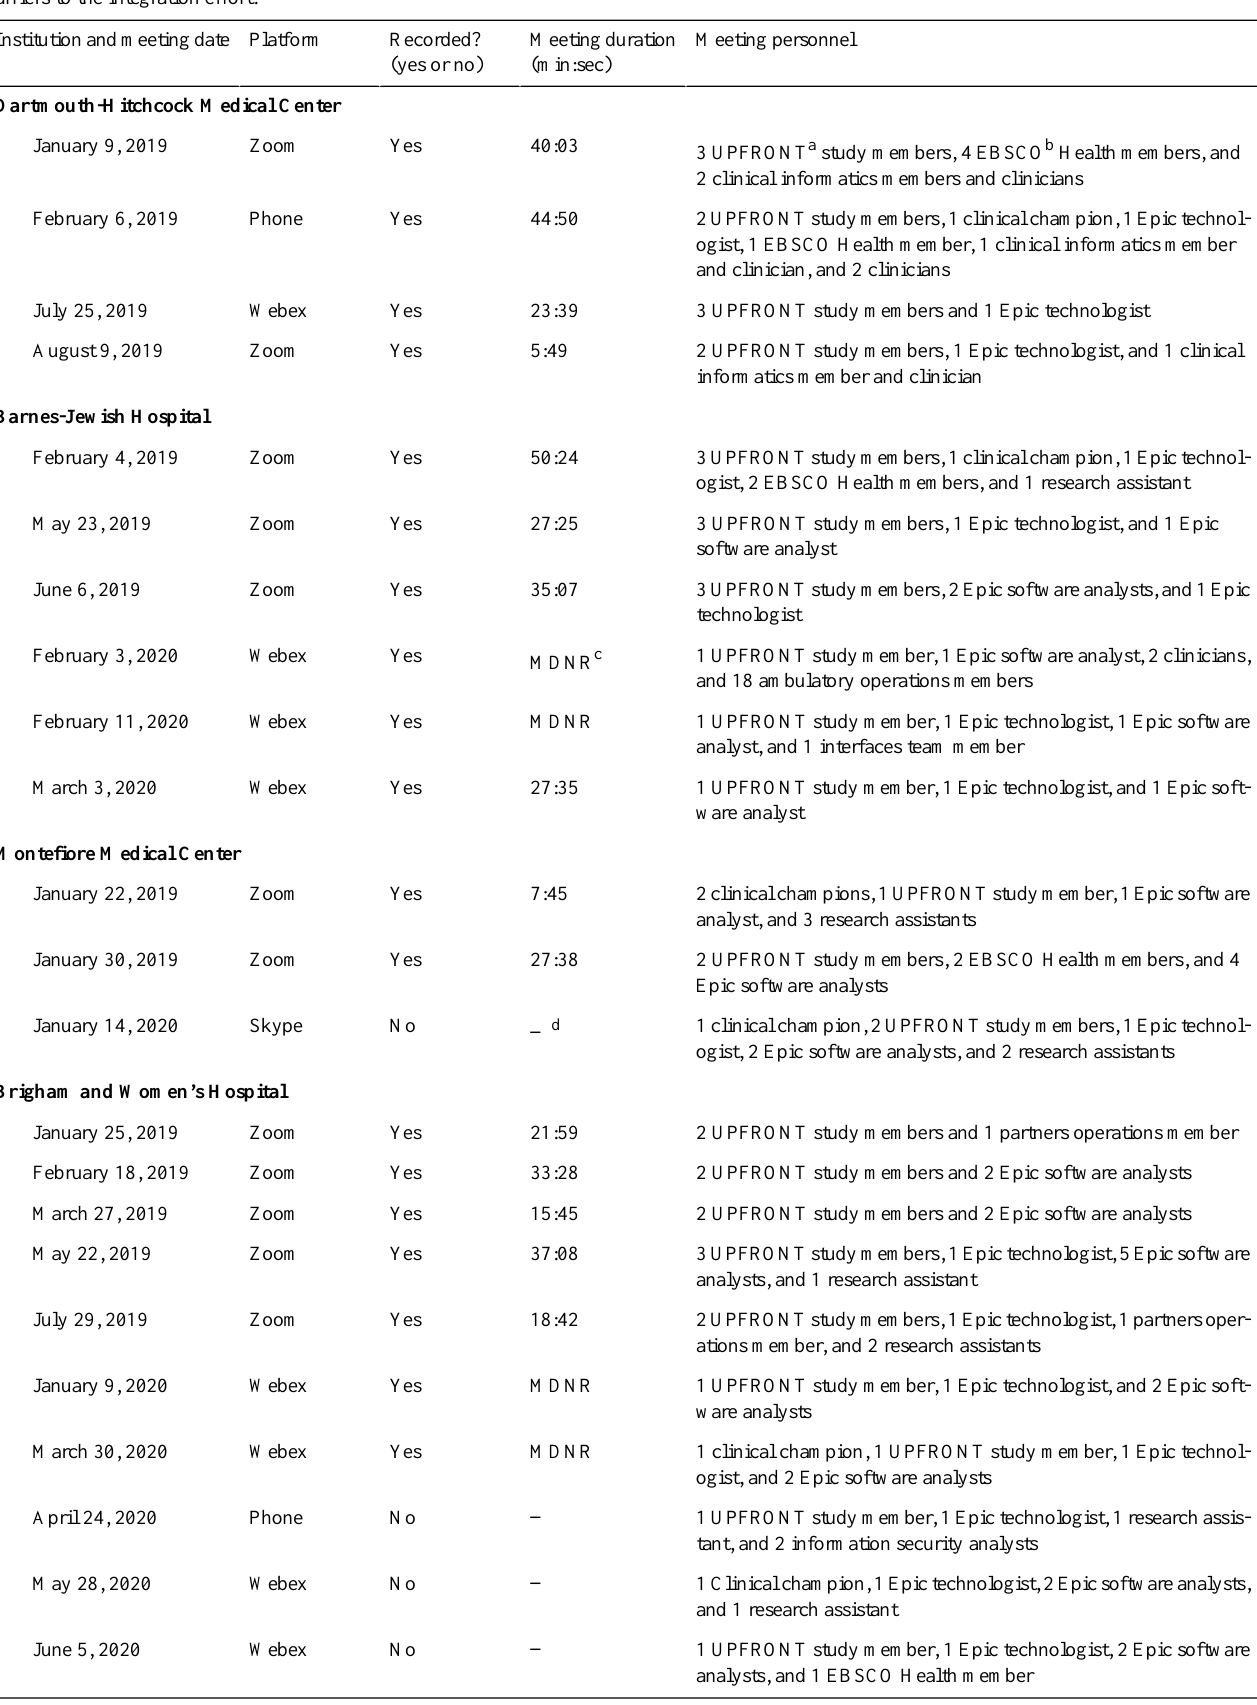
Table 2. Details of the 27 meetings that informed the steps to integrate the patient decision aid into the electronic health record and the facilitators and barriers to the integration